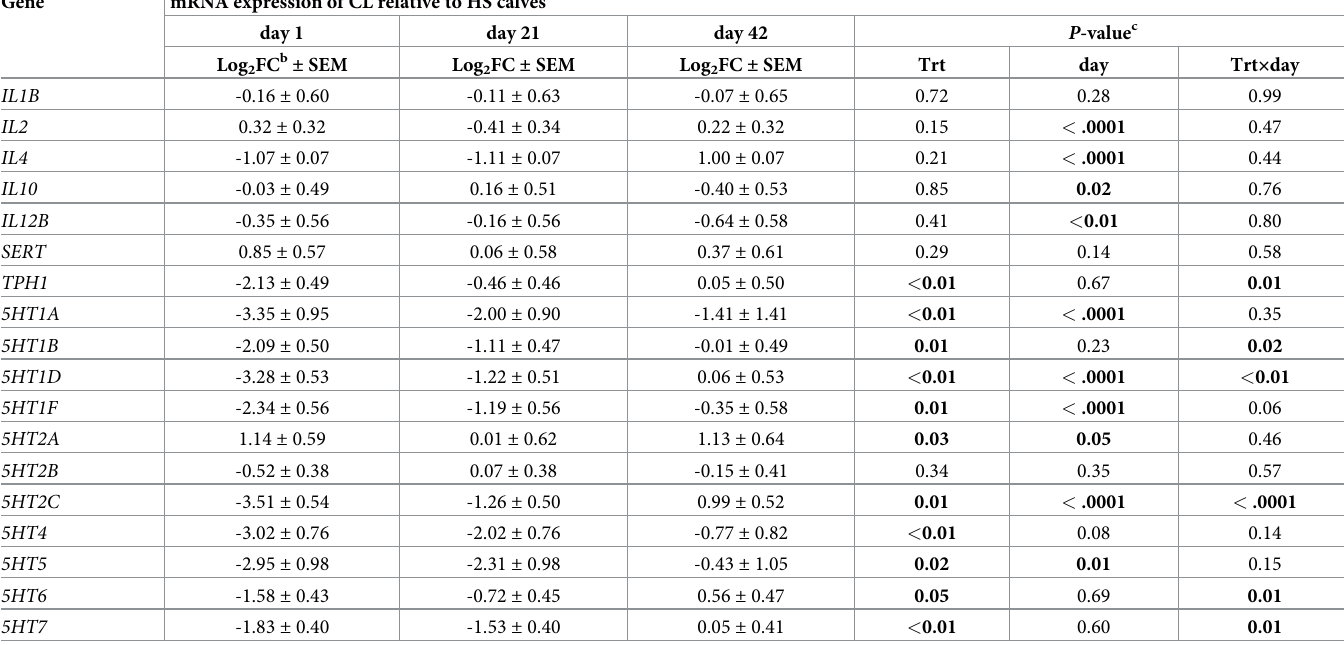
Table 2. (Continued) Gene mRNA expression of CL relative to HS calves